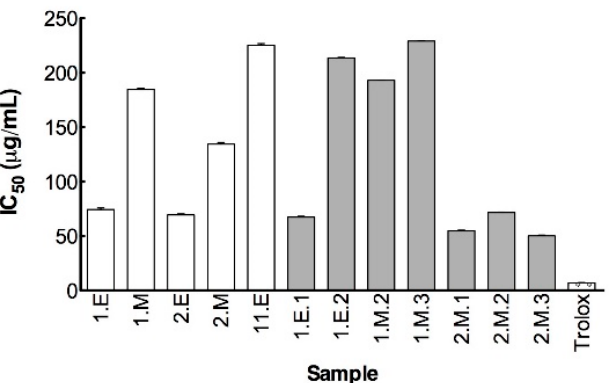
Figure 5. IC 50 values of DPPH scavenging activity by the extracts (light bars) and fractions thereof (dark bars). Trolox was used as reference.